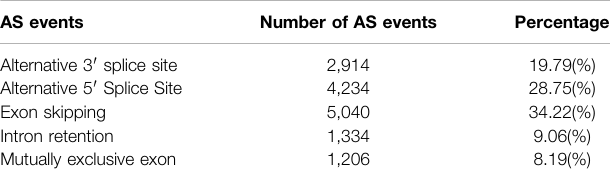
TABLE 3 | Number and percentage of AS